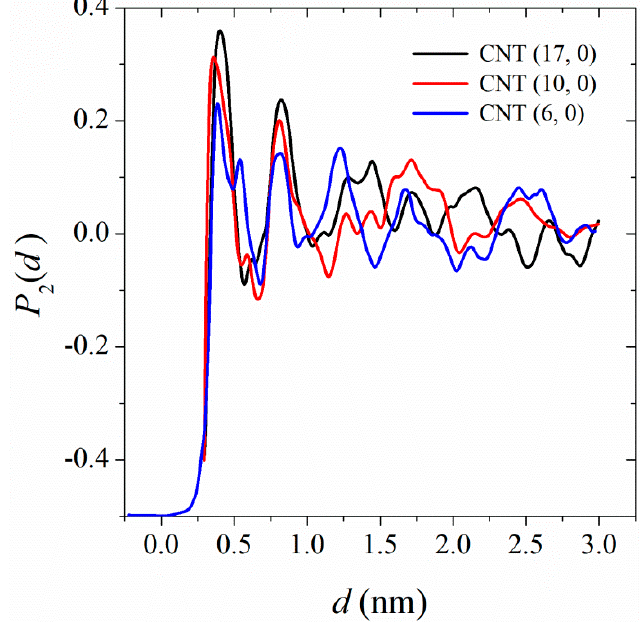
Figure 6. The second Legendre polynomial for the orientation of monomer’s end-to-end vector along the CNT axis as a function of monomer’s center-of-mass distance from the CNT surface.